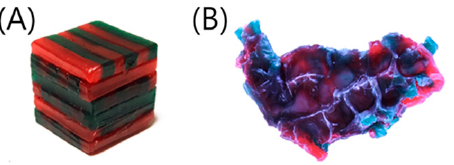
Figure 1. Preparation of a two-color wax cube ( A ) and a chewed wax cube ( B ) [26].